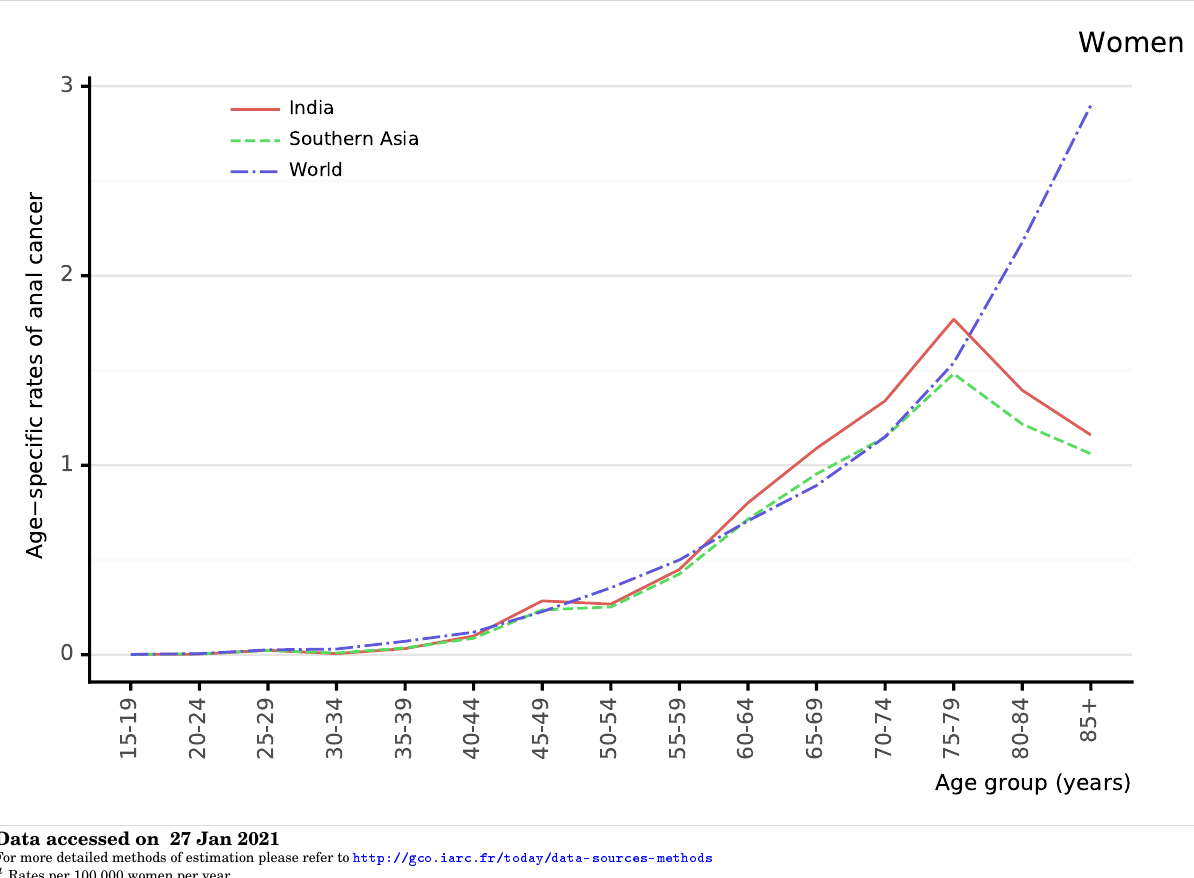
Figure 112: Comparison of age-specific anal cancer mortality rates among women by age in India, within the region, and the rest of